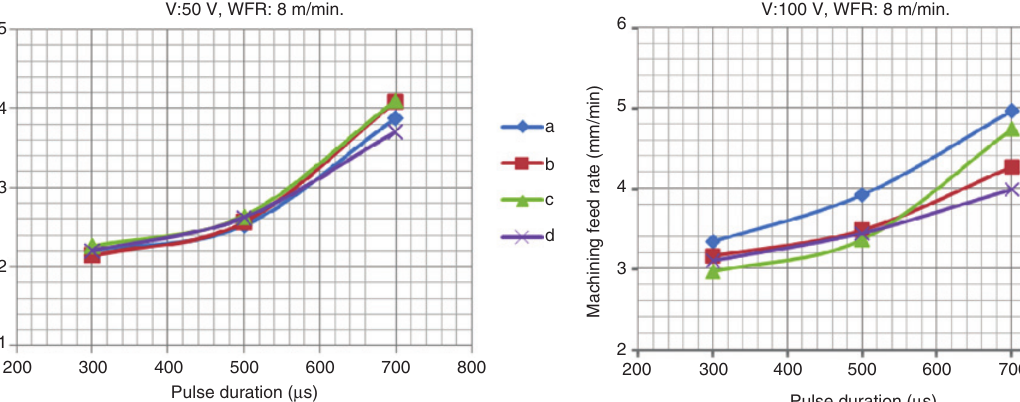
Figure 7 Machine feed rate: pulse duration.